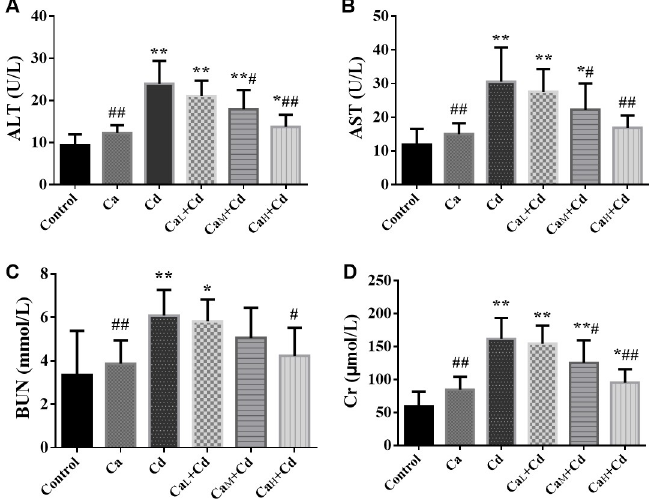
Fig 2. The activity of serum ALT (A) and AST (B) and the concentration of serum BUN (C) and Cr (D) in different groups. The data are shown as mean ± SD. � P < 0.05, compared with control-group. �� P < 0.01, compared with control-group. # P < 0.05, compared with Cd-group. ## P < 0.01, compared with